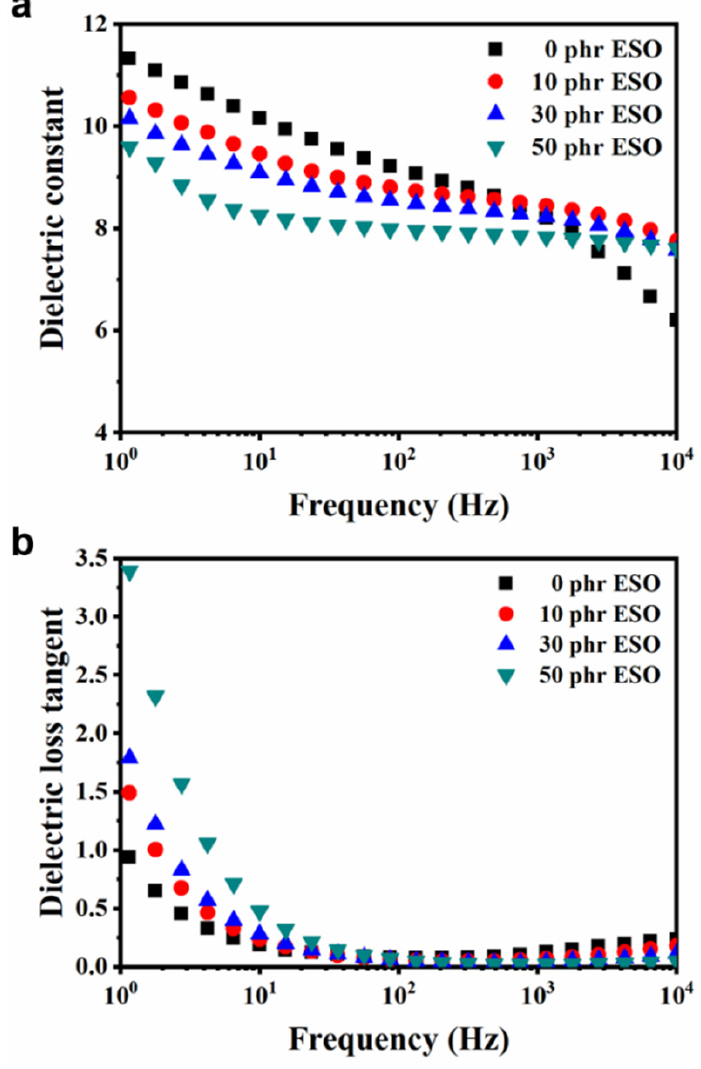
Figure 9. Frequency dependence of ( a ) ε r and ( b ) tan δ of Si747@BTO/ENR composites with various loadings of ESO.